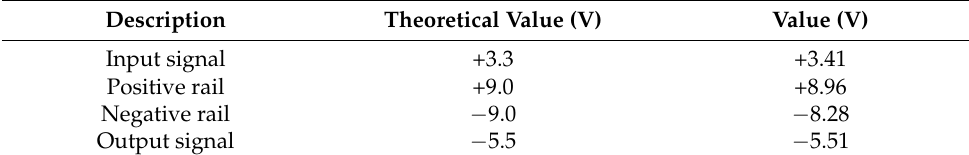
Table 1. Experimental validation of AMBB demonstration circuit.